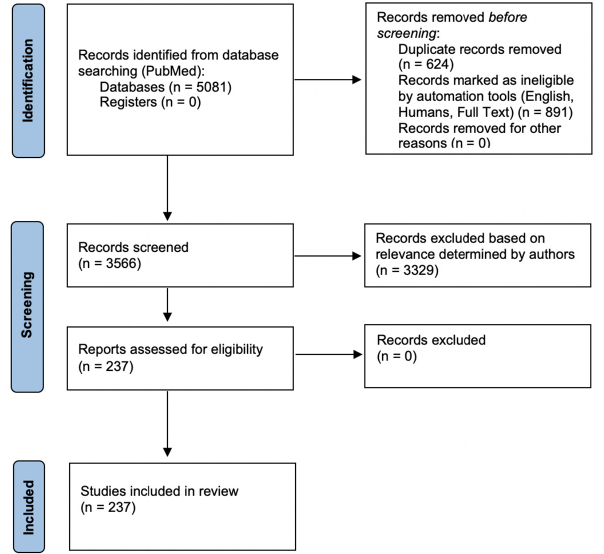
Figure 1. PRISMA flow diagram depicting methodology.